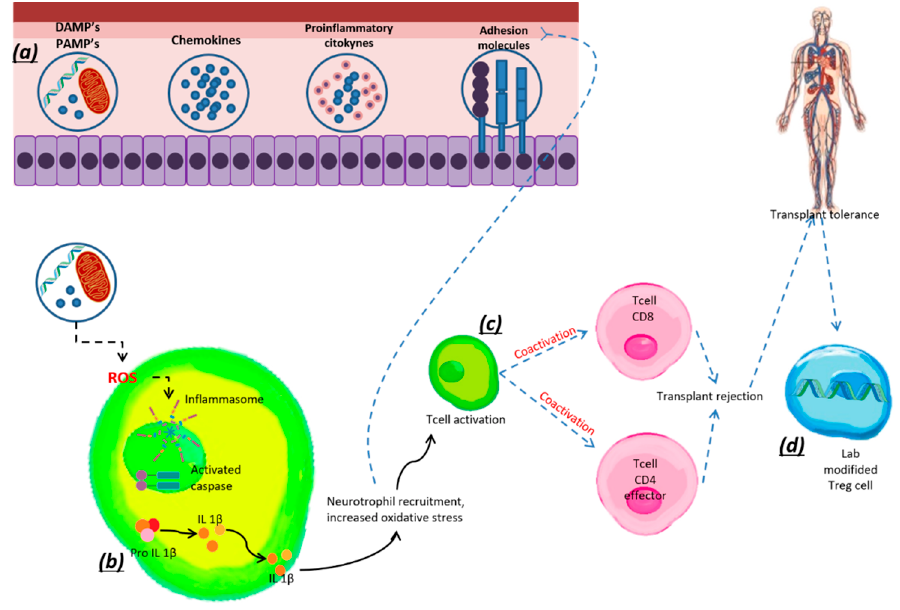
Figure 6. Pro-inflammatory mechanisms associated with the inflammation and activation of T cells. ( a ) PAMPs, DAMPs, chemokines, cytokines, and adhesion molecules that participate in inflammation ( b ) PAMPs and DAMPs, triggering a process of redox imbalance that favors the production of pro-inflammatory cytokines. ( c ) Aseptic activation of TCd8+ and TCd4+ cells, which leads to rejection of the transplanted organ. ( d ) Modified Treg cells induce tolerance to the transplant.